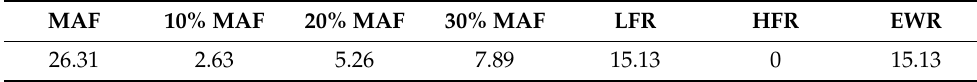
Table 4. EWR of the Kor River in Chamriz station by Smakhtin method (m 3 /s).